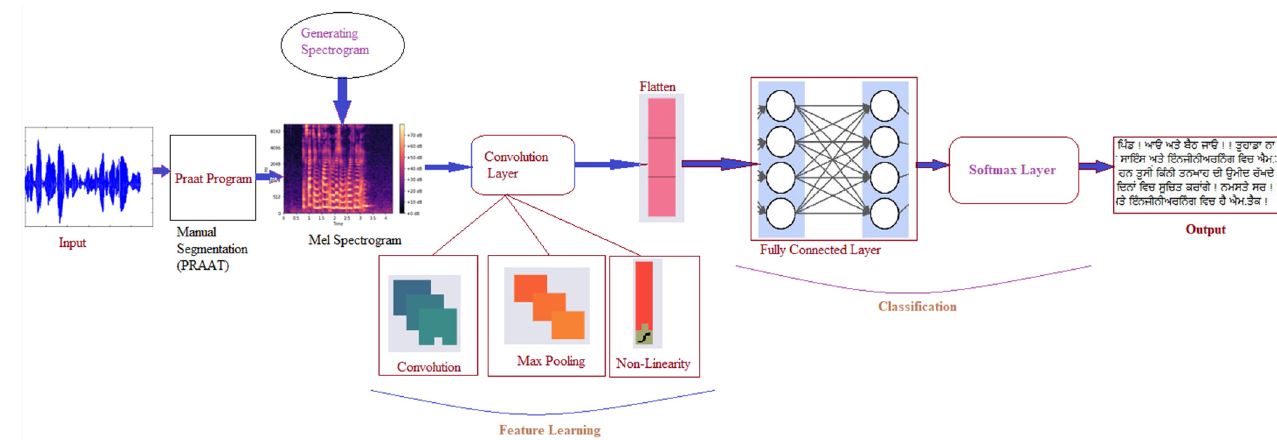
Figure 2. Framework for proposed work.